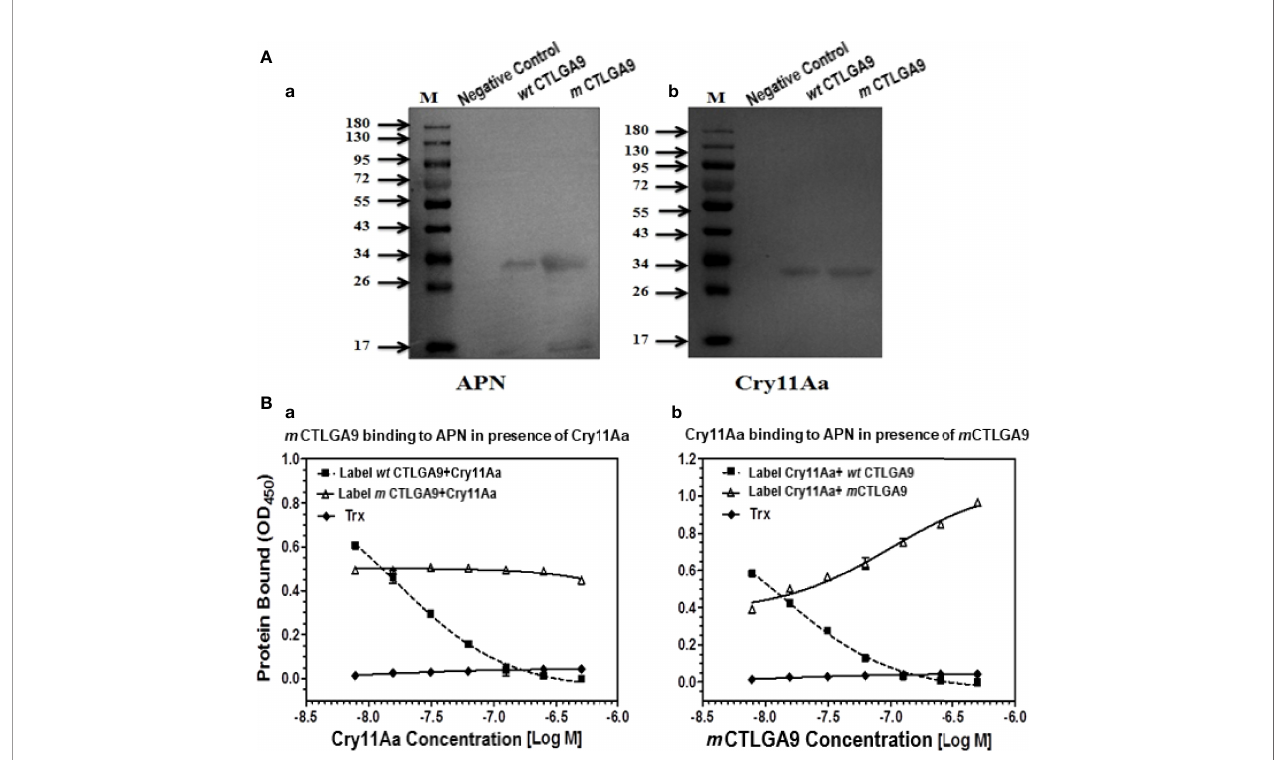
FIGURE 4 | The binding activity of mutant CTLGA9 protein with APN receptor and Cry11Aa toxin protein. (A (a, b)) Lane M: 180 kDa molecular mass marker (Thermo); Lane 2: Trx negative control; Lane 3: wt CTLGA9 (positive control); Lane 4: m CTLGA9. (B-a) Binding of biotinylated m and wt CTLGA9 (10 nm) to immobilized APN in the presence of increasing concentrations of unlabeled Cry11Aa (0-500nm); (B-b) Binding of biotinylated Cry11Aa to immobilized APN in the presence of increasing concentrations of unlabeled mutant and wt